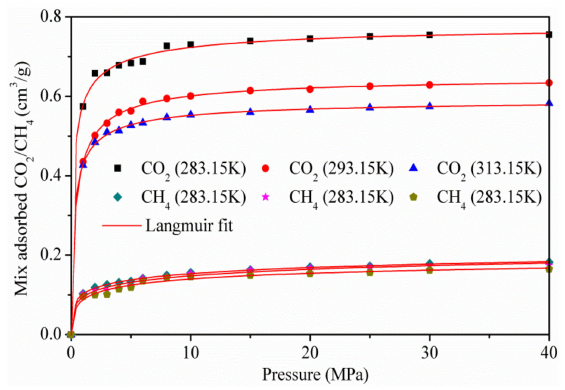
Figure 6. Isotherms of the CO 2 / CH 4 mixture on kaolinite.